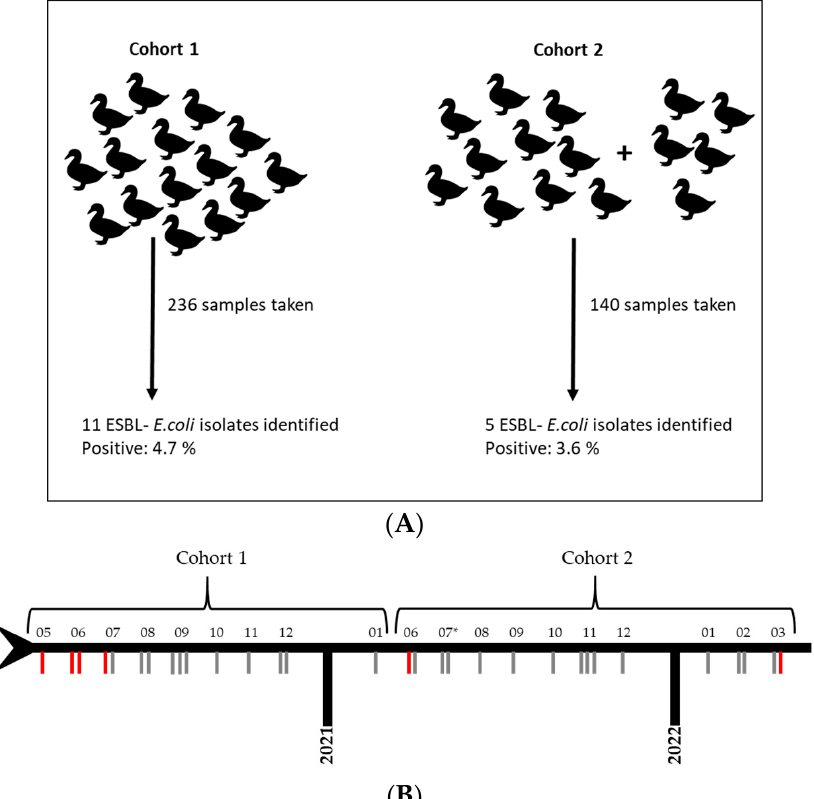
Figure 1. Schematic illustration of the sampling procedure and positive cases. ( A ) Two cohorts were sampled regularly. Cloacal swabs and pooled fecal samples were taken. Samples were investigated for extended-spectrum beta-lactamase (ESBL)- E. coli presence by bacterial cultivation. E. coli identification was additionally confirmed by whole genome sequencing. ( B ) Timeline of the sampling frequency (gray lines) starting in May 2020 until March 2022. Months (indicated as numbers) without sampling activity are not shown. Positive ESBL- E. coli results are shown in their order of appearance and highlighted as red lines. * indicates arrival of additional 5 animals in cohort 2.